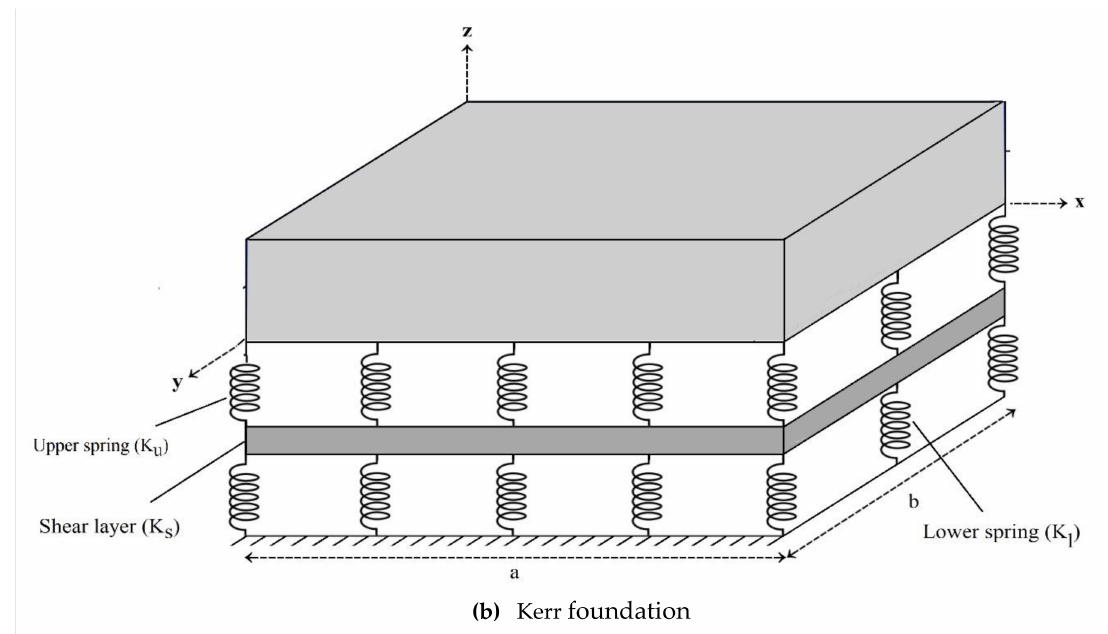
Figure 1. Rectangular plate embedded on and elastic